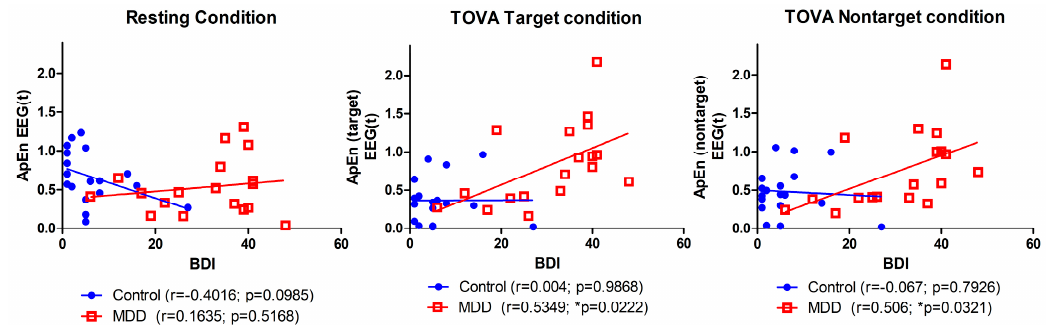
Figure 8. Correlation between BDI score and average ApEn among three conditions.